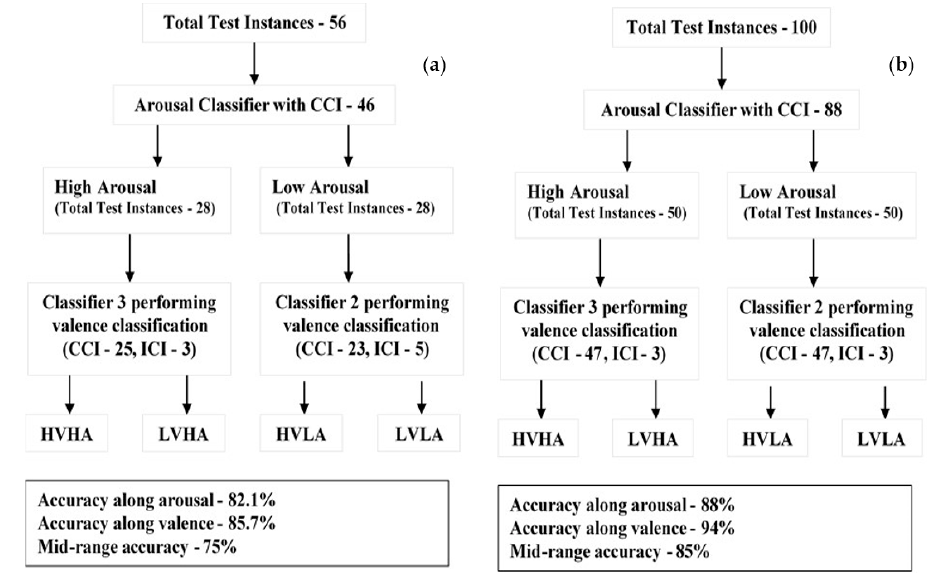
Figure 6. Comparison of existing results ( a ) [22], and ( b ) results obtained on frontal electrodes. We determined the effect of including Fp1 and Fp2 in the set of selected electrodes when classifying emotions along arousal and valence domains. Analysis was performed without including ERP data from Fp1 and Fp2 electrodes. It can be clearly seen from Ta ‐ bles 6 and 7 that the four ‐ class emotion classification accuracy reduced. A four ‐ class clas ‐ sification accuracy of 75% has been obtained, which is considerably lower than 83% ob ‐ tained with Fp1 and Fp2 data included in the classification. The classification results are shown in Table 6 and error analysis in Table 7. Here, two classifiers have been used in the emotion classification, as shown in Figure 7. Table 6. The confusion matrix on frontal electrodes except Fp1 and Fp2 using average ERPs. Confusion Matrix 14 Table 7. The error analysis of results on frontal electrodes except Fp1 and Fp2. Error Analy ‐ sis